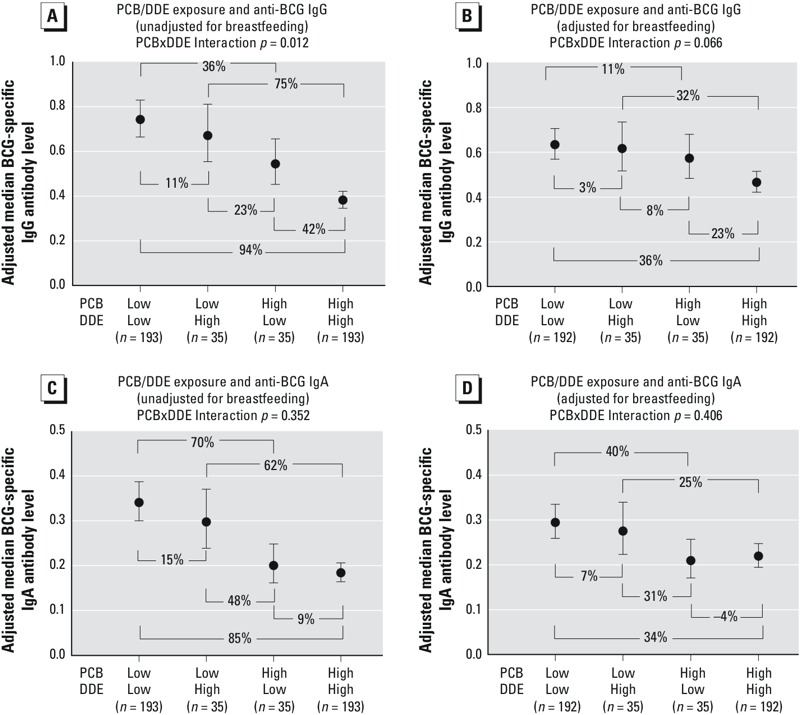
Six-month infant serum PCB and DDE concentrations, categorized as above (“high”) and/or below (“low”) the median value, in relation to 6-month BCG-specific IgG (A,B) and IgA (C,D). Results are adjusted for maternal ethnicity, education, and age (A,C) and maternal ethnicity, education, age, and duration of exclusive breastfeeding (B,D). Adjusted numerical estimates are available in Table S4.